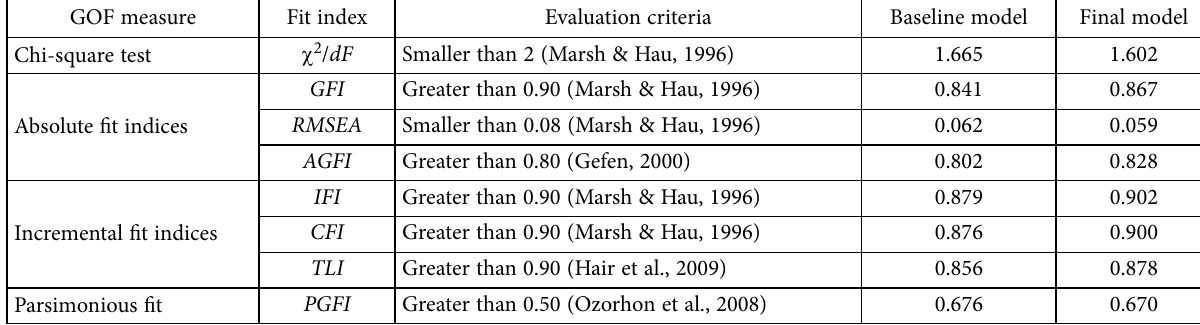
Table 5. Results of goodness of fit (GOF)